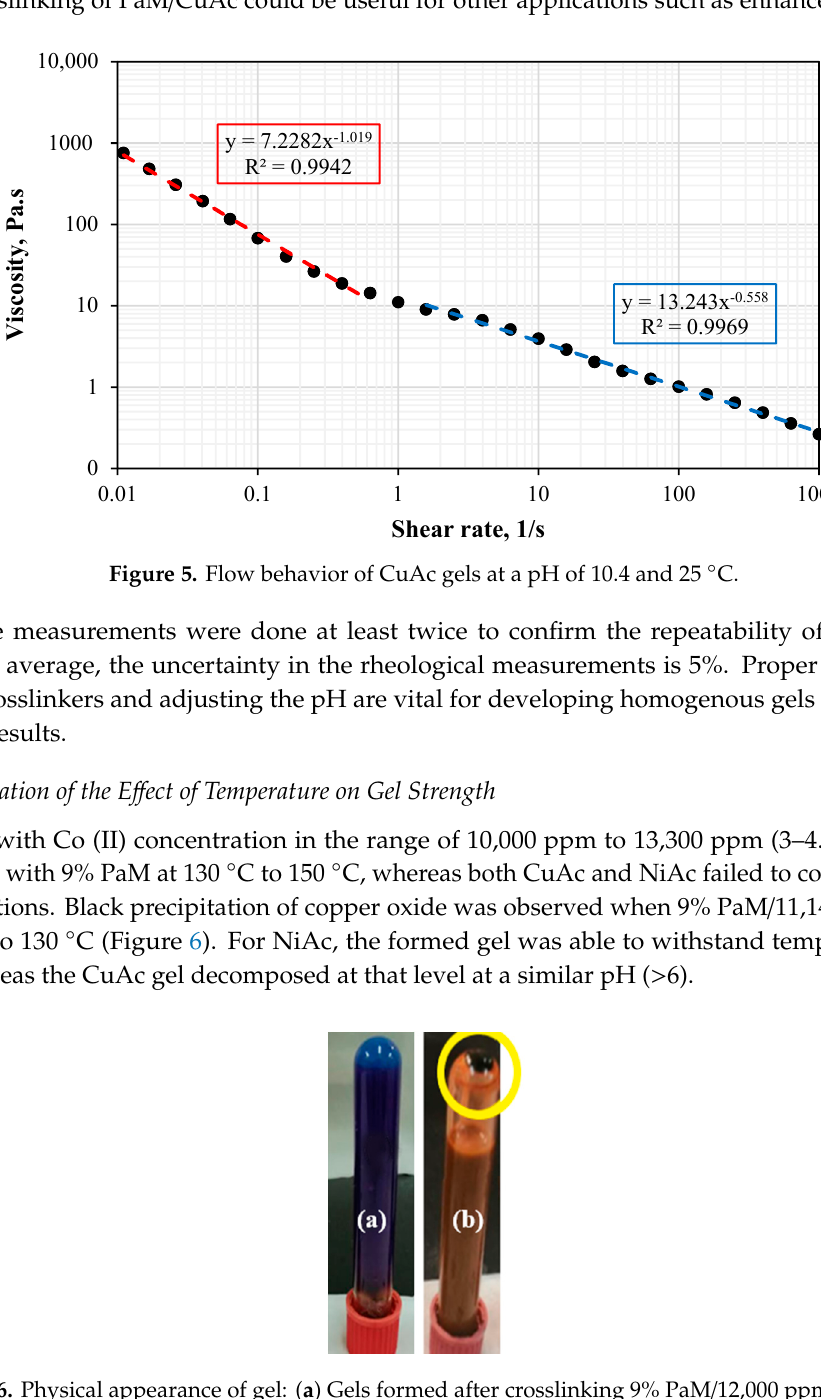
Figure 4. Effect of Co (II) concentration on mature gel storage modulus (25 °C, pH = 7.25).